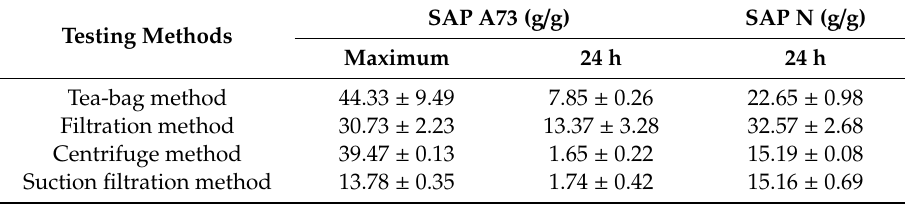
Table 3. Maximum absorptivity and absorptivity at 24 h in cement